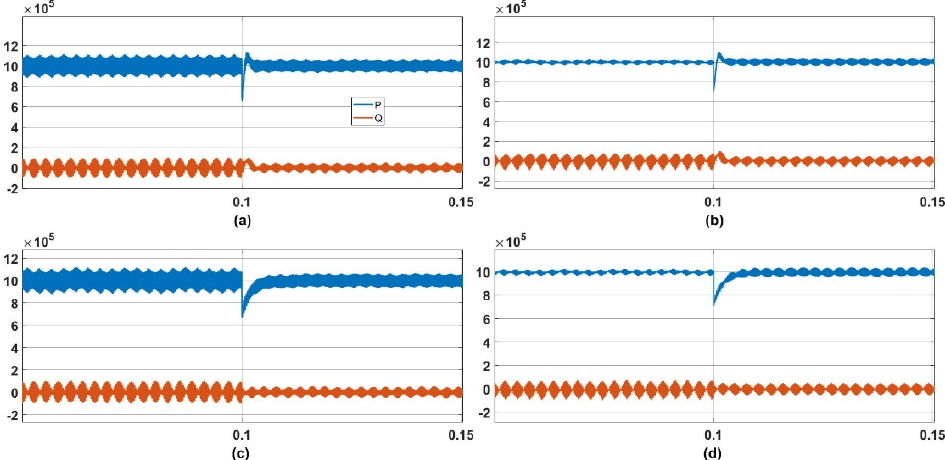
Figure 17. Three-phase pcc currents in a balance voltage dip in the case of ( a ) 2L- αβ , ( b ) 3L- αβ , ( c ) 2L-dq and ( d ) 3L-dq.